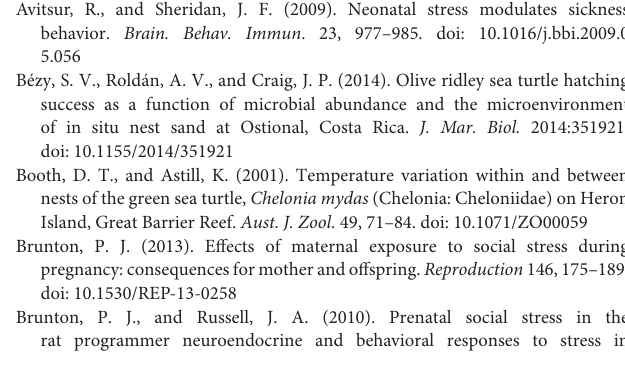
differ significantly at different location of the same beach